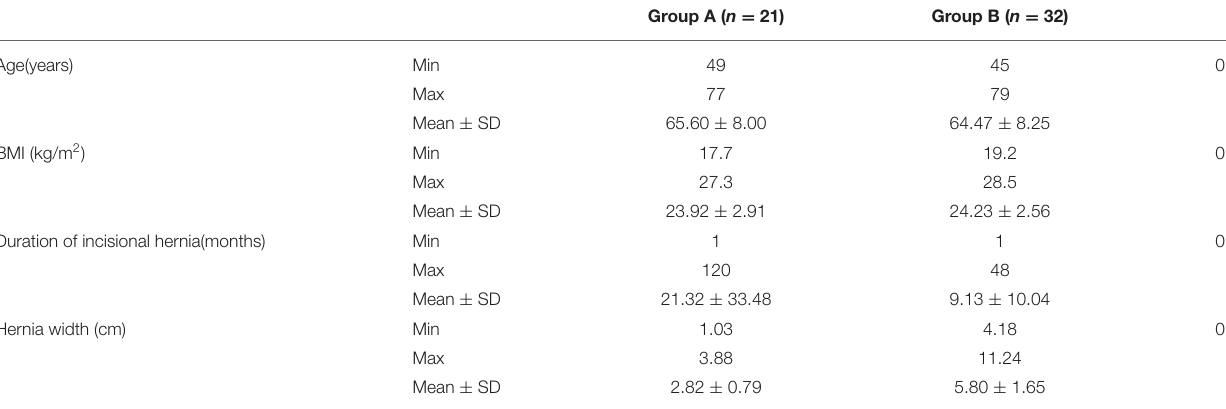
TABLE 1 | Basic characteristics of group A and group B.